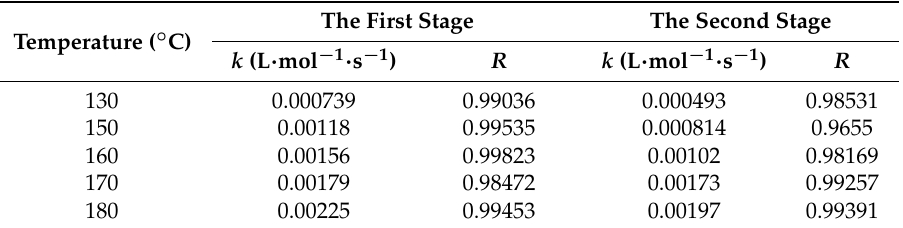
Table 3. The calculated constants and correlation coefficient under different reaction temperatures.